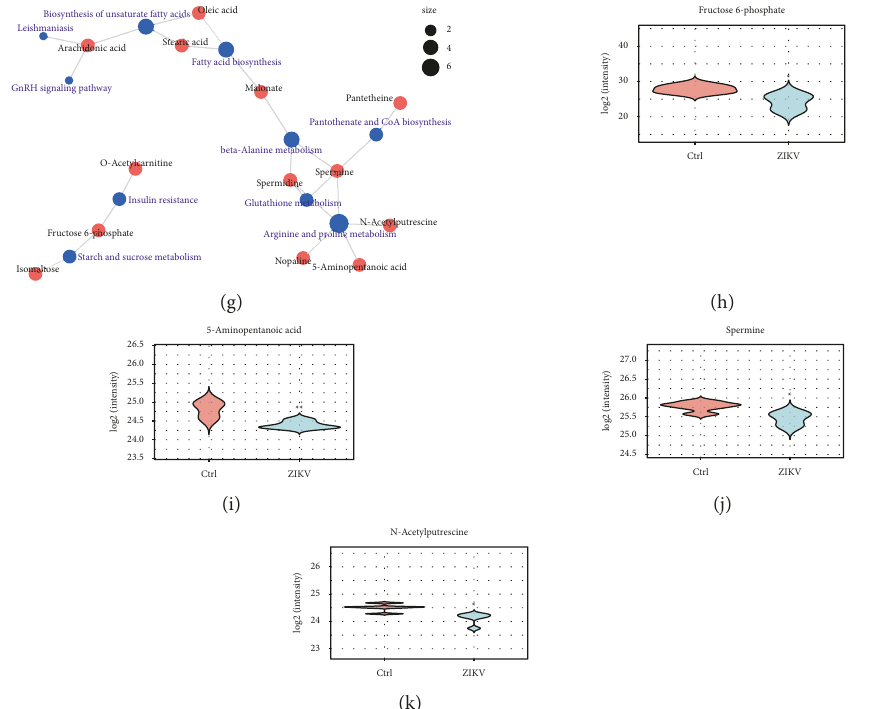
Figure 3: Urinary metabolite profiles reflect the characteristics of ZIKV infections. PCA in (a) the positive-ion mode and (b) the negative- ion mode. PLS regression in (c) the positive-ion mode and (d) the negative-ion mode. (e) Metabolite cluster heatmap of urine. (f), (g) A metabolomic view of pathway analysis to show the most obvious metabolic pathways affected by ZIKV infection. (h–k) Violin plot of metabolites used to differentiate ZIKV infection from controls. (h) Fructose 6-phosphate, (i) 5-aminopentanoic acid, (j) spermine, and (k)